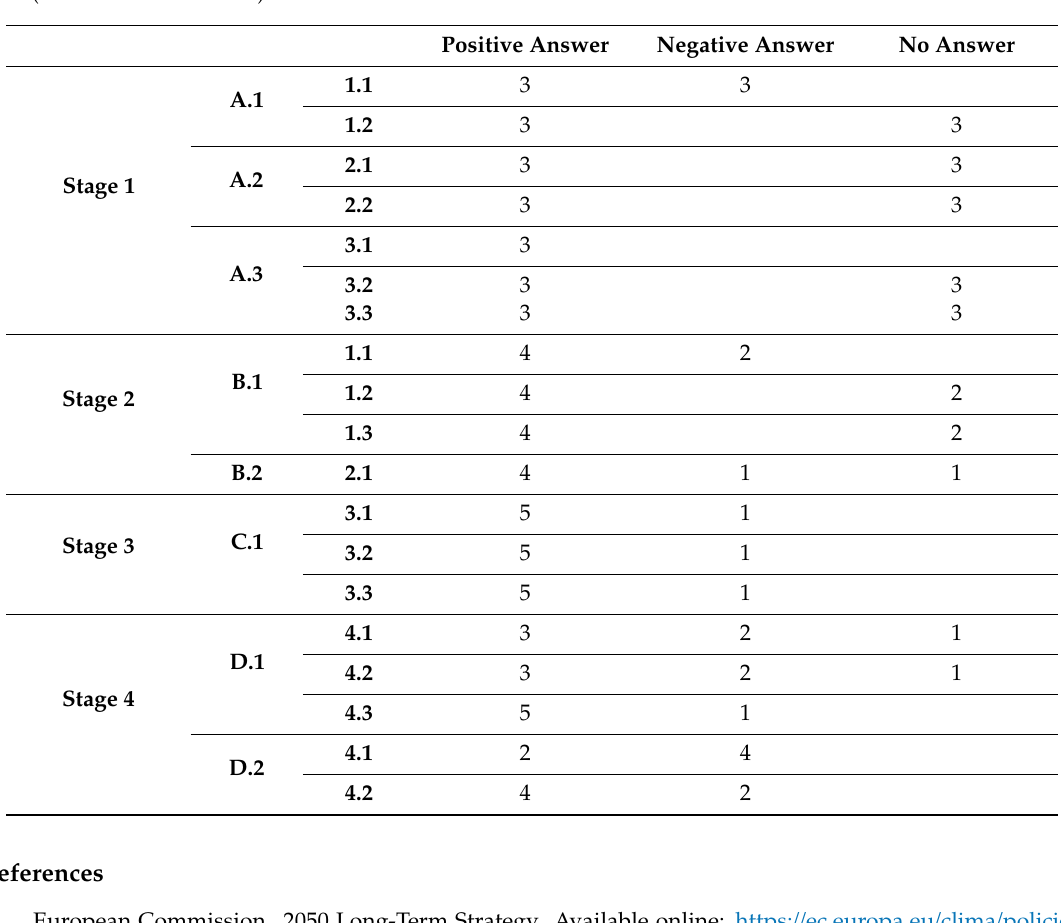
Table A1. Quantitative analysis of the answers received in the expert assessment from the six WinWind partner countries. Positive, negative and absent answers are represented as absolute values (6 observations in